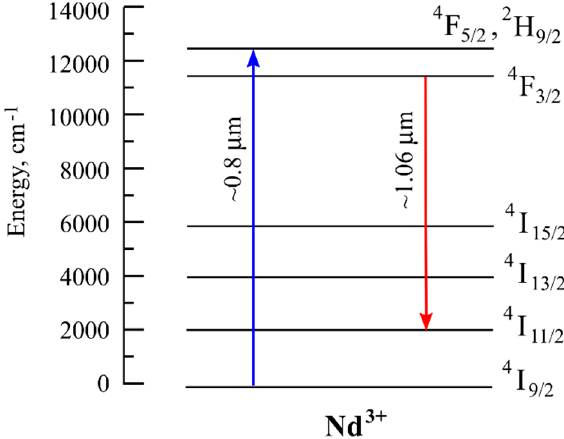
Figure 3. Simplified energy level diagram for Nd-doped tellurite glass.